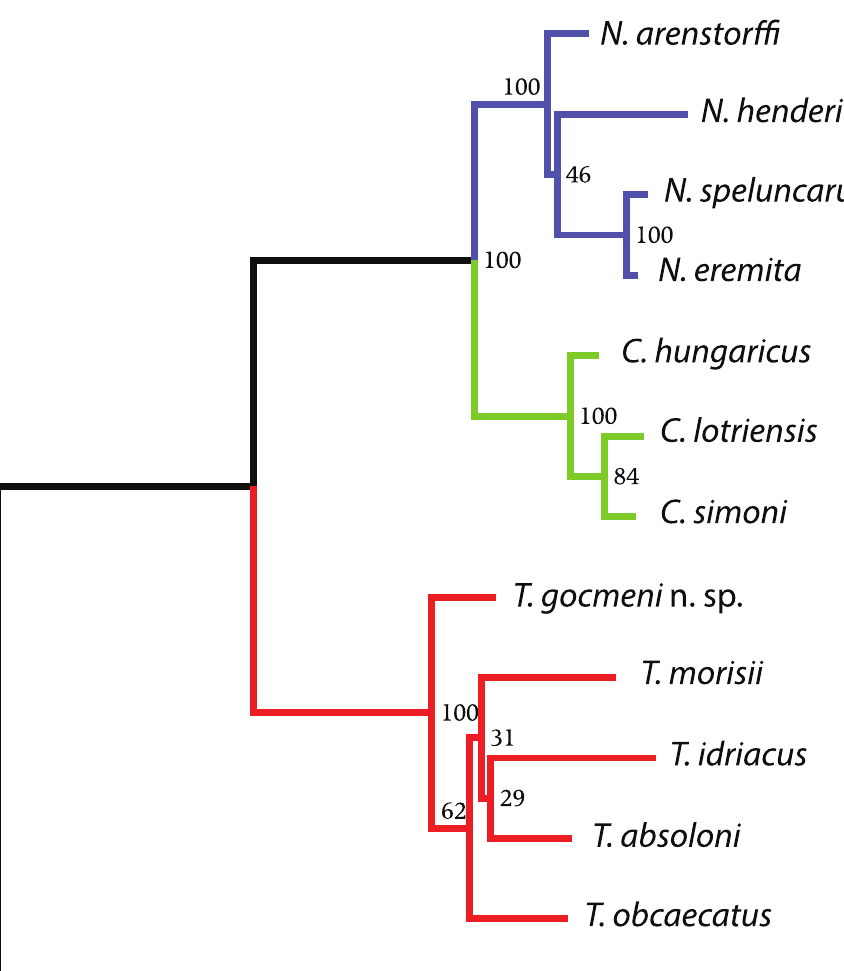
Figure 1. ML tree inferred using the concatenated dataset of cox1 , rrnL mtDNA and H3 nuDNA gene fragments. Numbers next to nodes correspond to bootstrap support values. The tree was rooted using Canarionesticus quadridentatus from the Canary